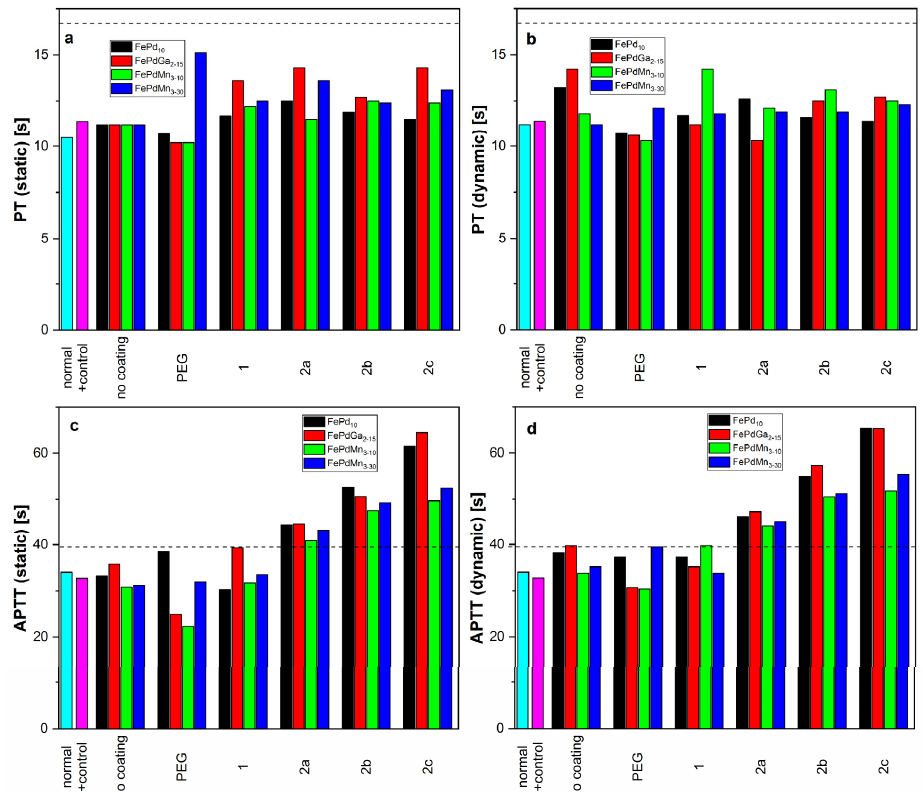
Figure 5. Average PT and APTT values of uncoated and coated FePd ribbons in static (( a ): PT, ( c ): APTT) and dynamic (( b ): PT, ( d ): APTT) conditions; the dashed line represents the respective maximum normal range.